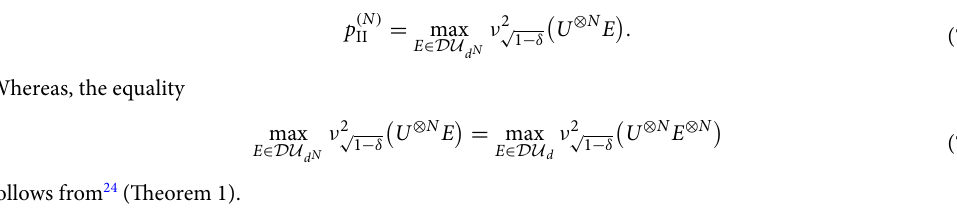
Figure 2. Numerical ranges W ( U ⊗ N ) (polytopes) and √ 1 U 2 with eigenvalues 1 and e π i 3 , for N U ∈